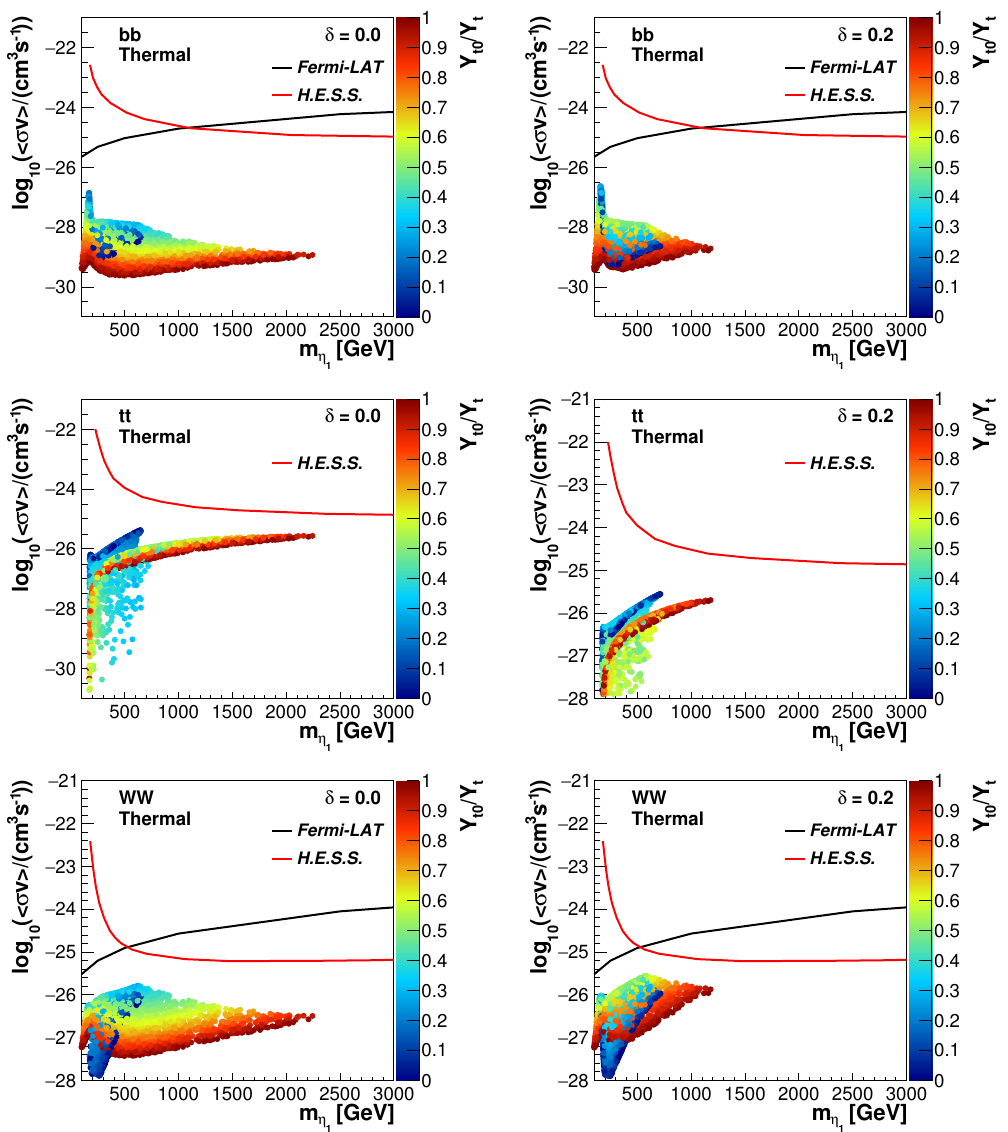
Figure 8 . Theoretical prediction (coloured region) for the velocity-averaged cross section for (cid:17) 1 annihilation into bottom pair (top row), top pair (middle row) and WW (bottom row) for (cid:14) = 0 (left) and 0 : 2 (right), compared to the upper limits from Fermi-LAT (black) and HESS (red) gamma- ray observation. The colour code indicates the variation of the Yukawa coupling Y f 0 from 0 to Y f . The cross sections are rescaled to the thermal relic